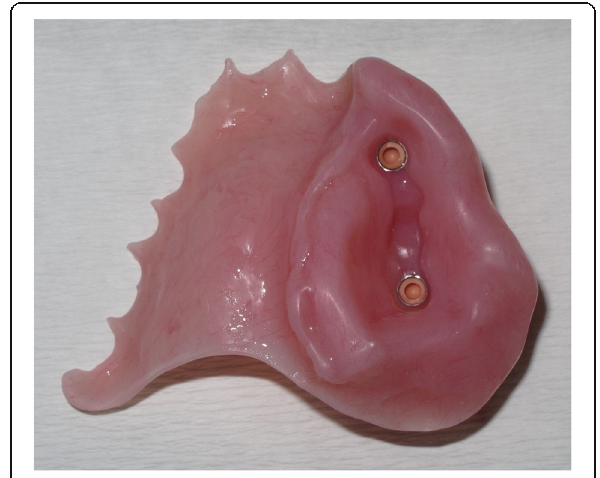
Fig. 6 Intaglio surface of definitive acrylic obturator with bar attachments in place. Note the absence of any other retaining clasps and the simple nature of this prosthesis